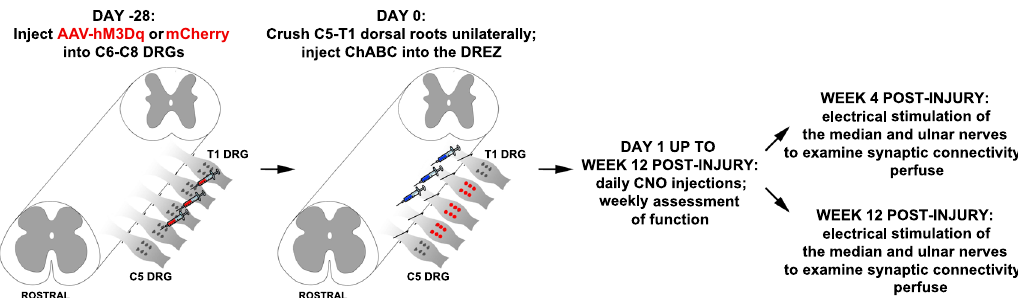
Fig. 4 Timeline of the in vivo experiments. Schematic summarizing the timeline and experimental